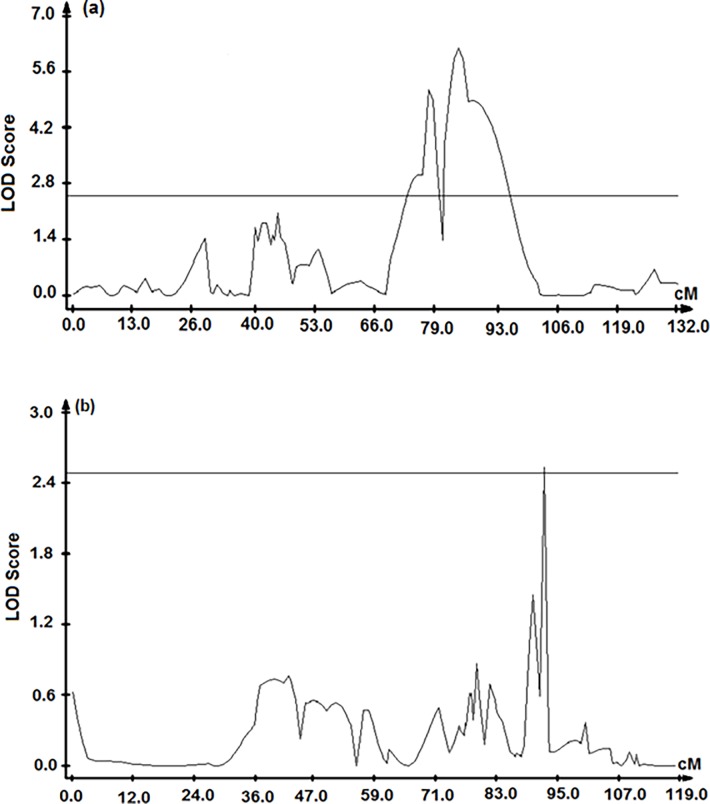
QTL identified in the Synthetic W7984 × Opata M85 RIL population which were associated with grain number per spike (a) under water stress during meiosis, located on chromosome 5A and (b) under normal watering, located on chromosome 2A using composite interval mapping. The horizontal bars indicate the significant LOD thresholds for the QTL detection which was set at ≥ 2.5 for both treatments.